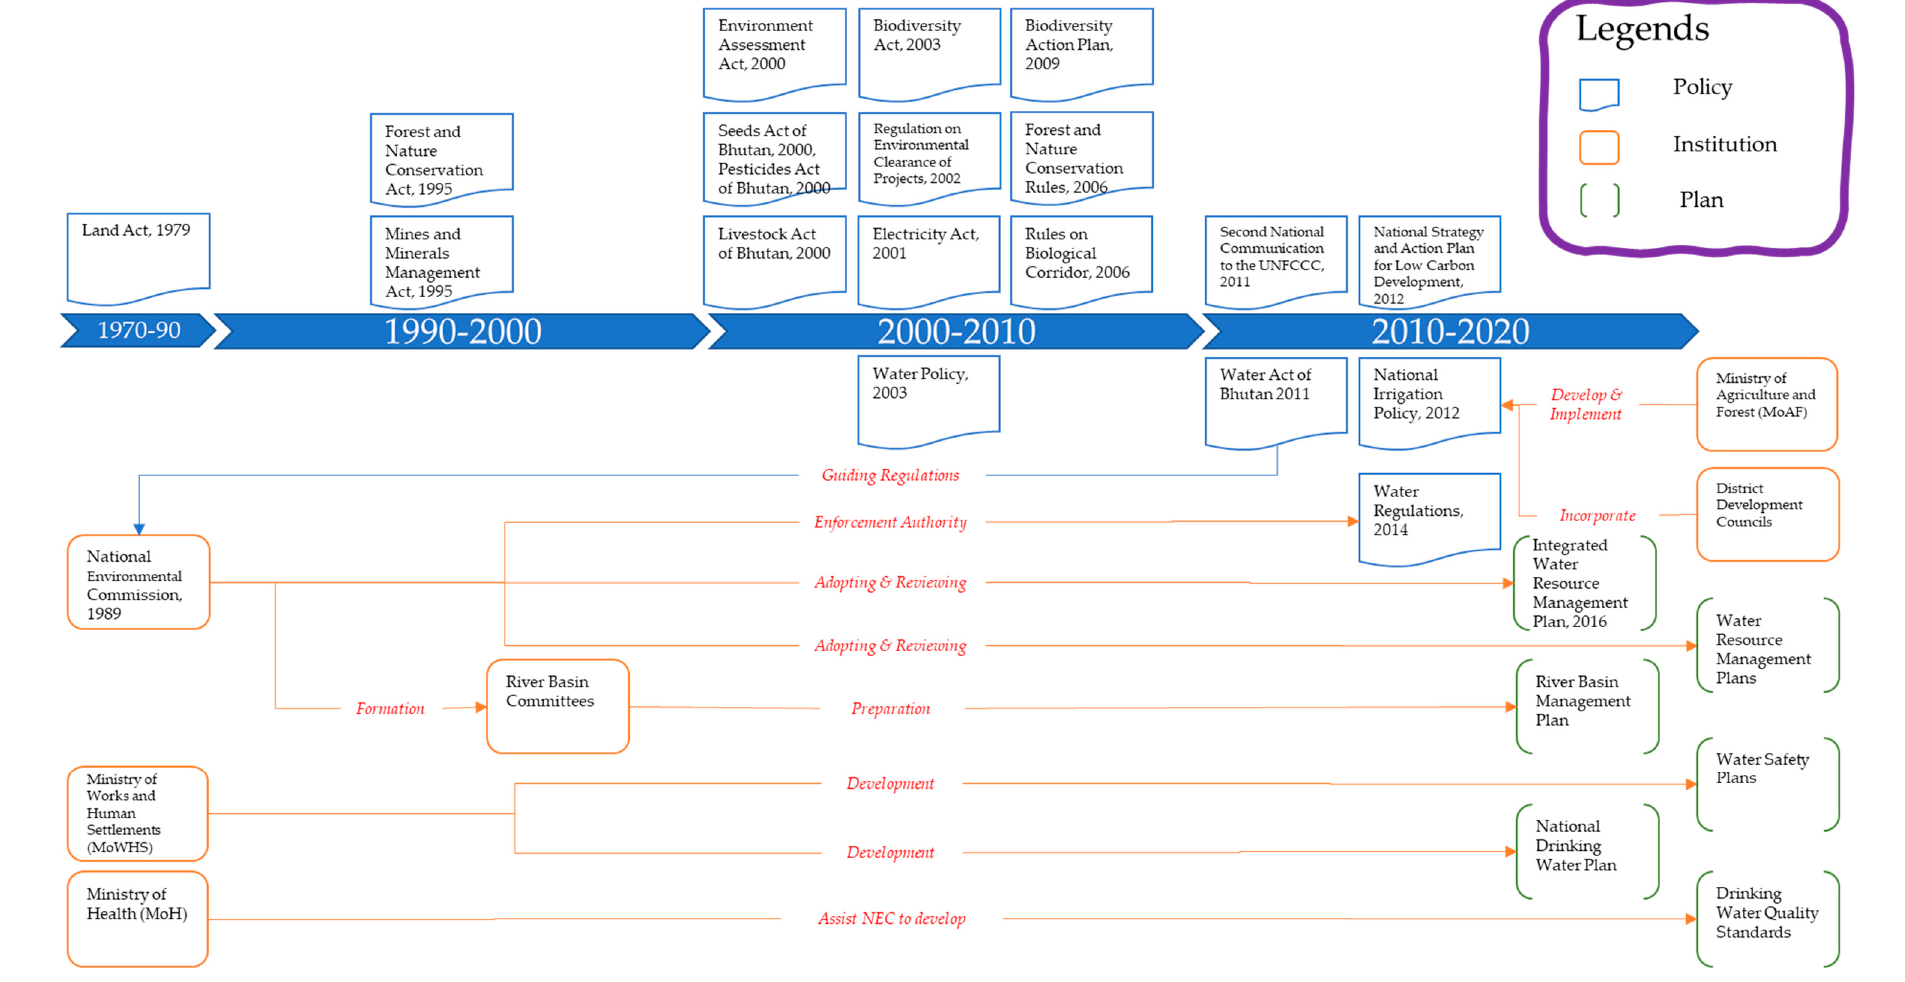
Figure 4. Timeline of policies, acts, and regulations and the connectivity between institutes, policies, and plans.